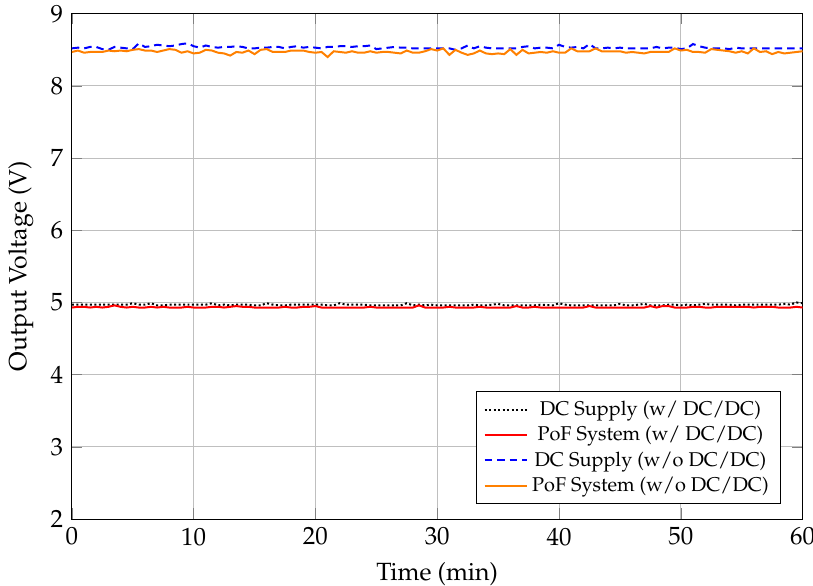
Figure 4. Stability comparison between PoF system and a conventional DC supply with and without the DC/DC converter at 5 V and 8.5 V, respectively, over 60 min.